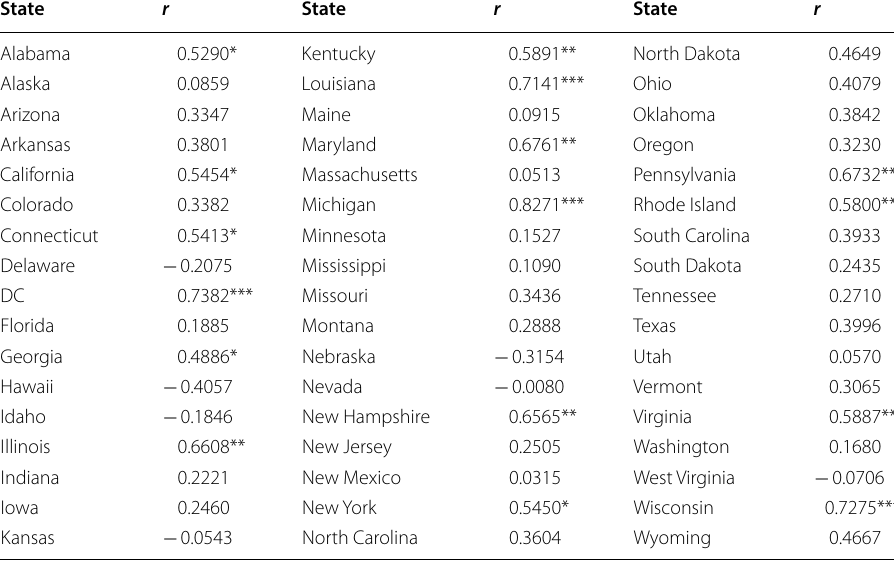
Table 7 Correlations between google trends data and Tuberculosis cases by state